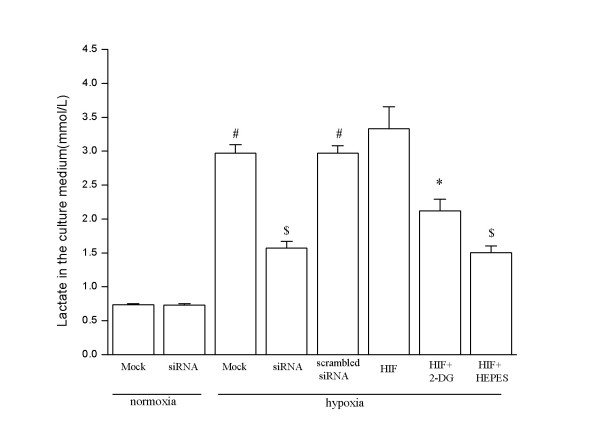
Measurement of lactate levels in the cell culture medium. The media from cell cultures were collected after transfection of the cells with HIF-1α siRNA vector or a HIF-1α expression plasmid and exposure to hypoxic conditions for 24 h. Lactate concentration was measured using a commercial kit (n = 5 in each group). $, P < 0.05 compared to normoxic mock transfected and HIF-1α siRNA; *, P < 0.05 compared to hypoxic HIF-1α siRNA and HIF-1α expression vector with HEPES; #, P < 0.05 compared to hypoxic HIF-1α expression vector with or without 2-DG. siRNA: A549 cells transfected HIF-1α siRNA vector, Mock: mock-transfected, HIF: A549 cells transfected with HIF-1α expression plasmid, HIF+2-DG: Cells transfected with HIF-1α expression plasmid and cultured with 2-DG, HIF+HEPES: Cells transfected with HIF-1α expression plasmid and cultured with medium containing HEPES.